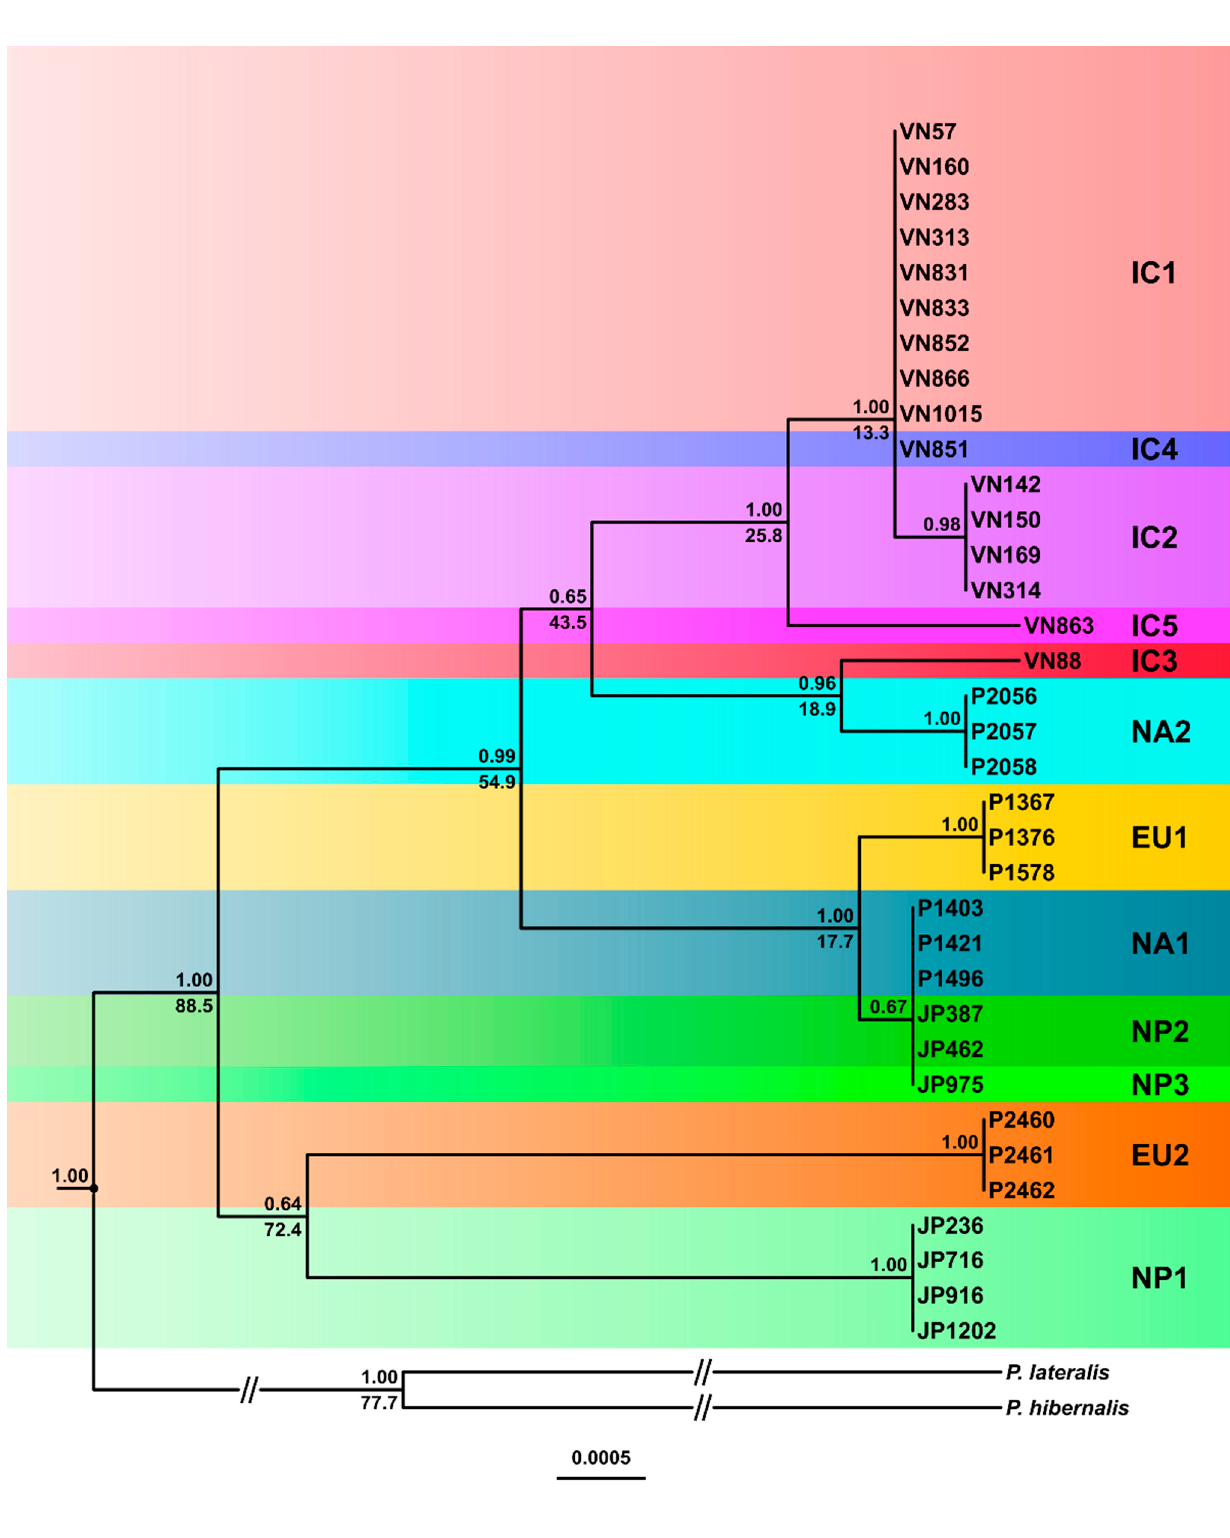
Figure 7. Fifty percent majority rule consensus tree derived from Bayesian inference analysis of a five-locus mitochondrial ( cox1 , cox2 , nadh1 , Prv8 and Prv9) dataset of the five Indochinese phenotype groups (IC1-5), the three Japanese phenotype groups (NP1-3) and the four known lineages (EU1, EU2, NA1 and NA2) of Phytophthora ramorum . Bayesian posterior probabilities and relative divergence times (in %) are indicated above and below branches, respectively. Phytophthora hibernalis and P. lateralis were outgroup taxa. Scale bar = 0.0005 expected changes per site per branch.